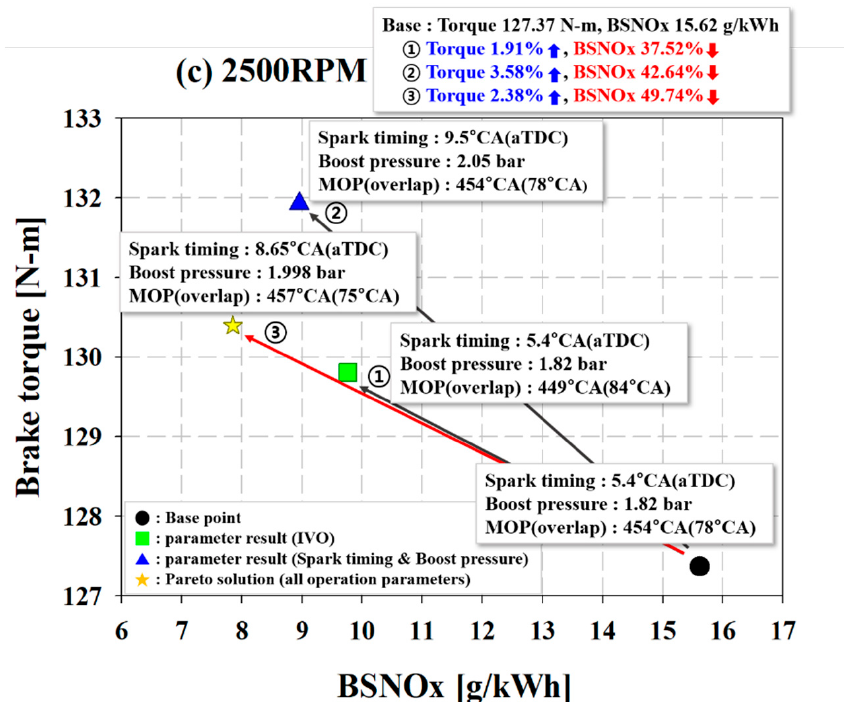
Figure 14. ( a ) Comparison of the Pareto solution and DoE simulation results at 1600 RPM. ( b ) Comparison of the Pareto solution and DoE simulation results at 1800 RPM. ( c ) Comparison of the Pareto solution and DoE simulation results at 2500 RPM.